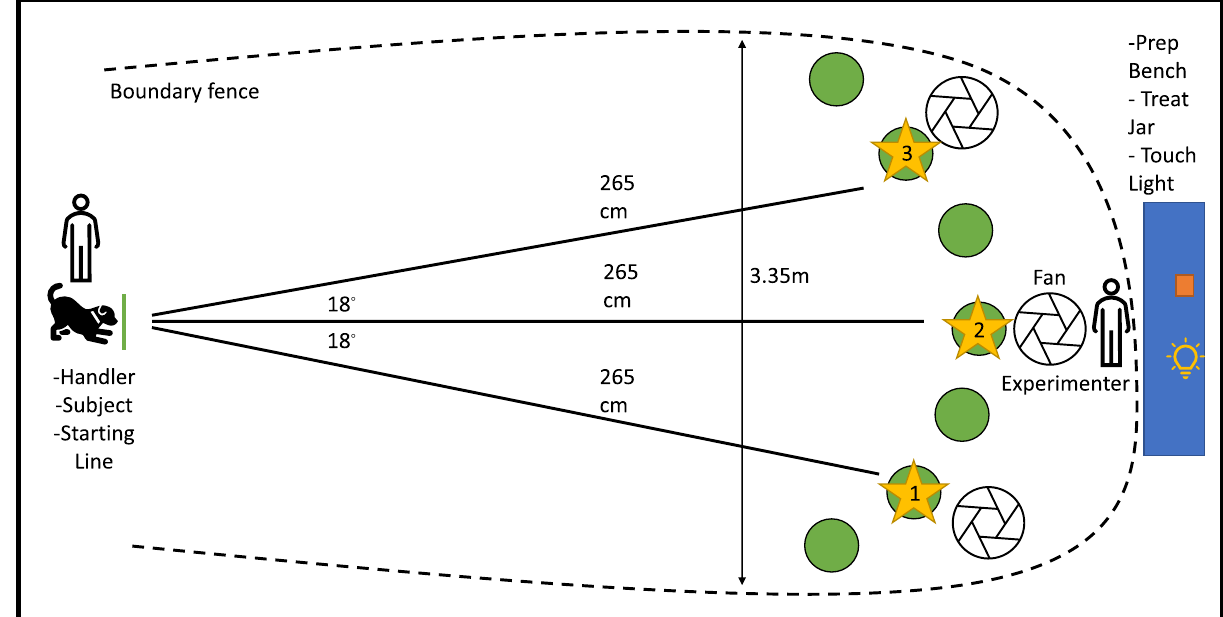
Figure 1. Experimental set up for the olfaction test. The dog is positioned behind the starting line before the trial begins. Phosphorescent dots are placed on the green circles to designate the treat locations and provide guides on where to place the treats in the dark-phase. Fans are angled toward the starting line behind the treat containers. The experimenter collects a treat from the workbench area before sealing the container and walking to the starting line to present the treat to the dog. The experimenter places the treat in a designated open container on the workbench then places the baited and sham containers in their designated positions, moving from position 1 to position 3 (designated by star